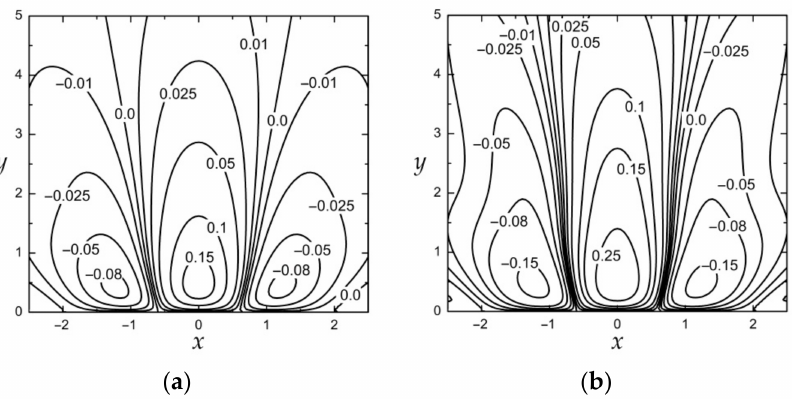
Figure 4. The full-field distributions of the thermal stress σ yy [GPa] for orthotropic composite materials with properties given in Table 2 due to the temperature field with Fourier image (26) at τ 0 = 1 : ( a ) material 3 , ( b ) material 4